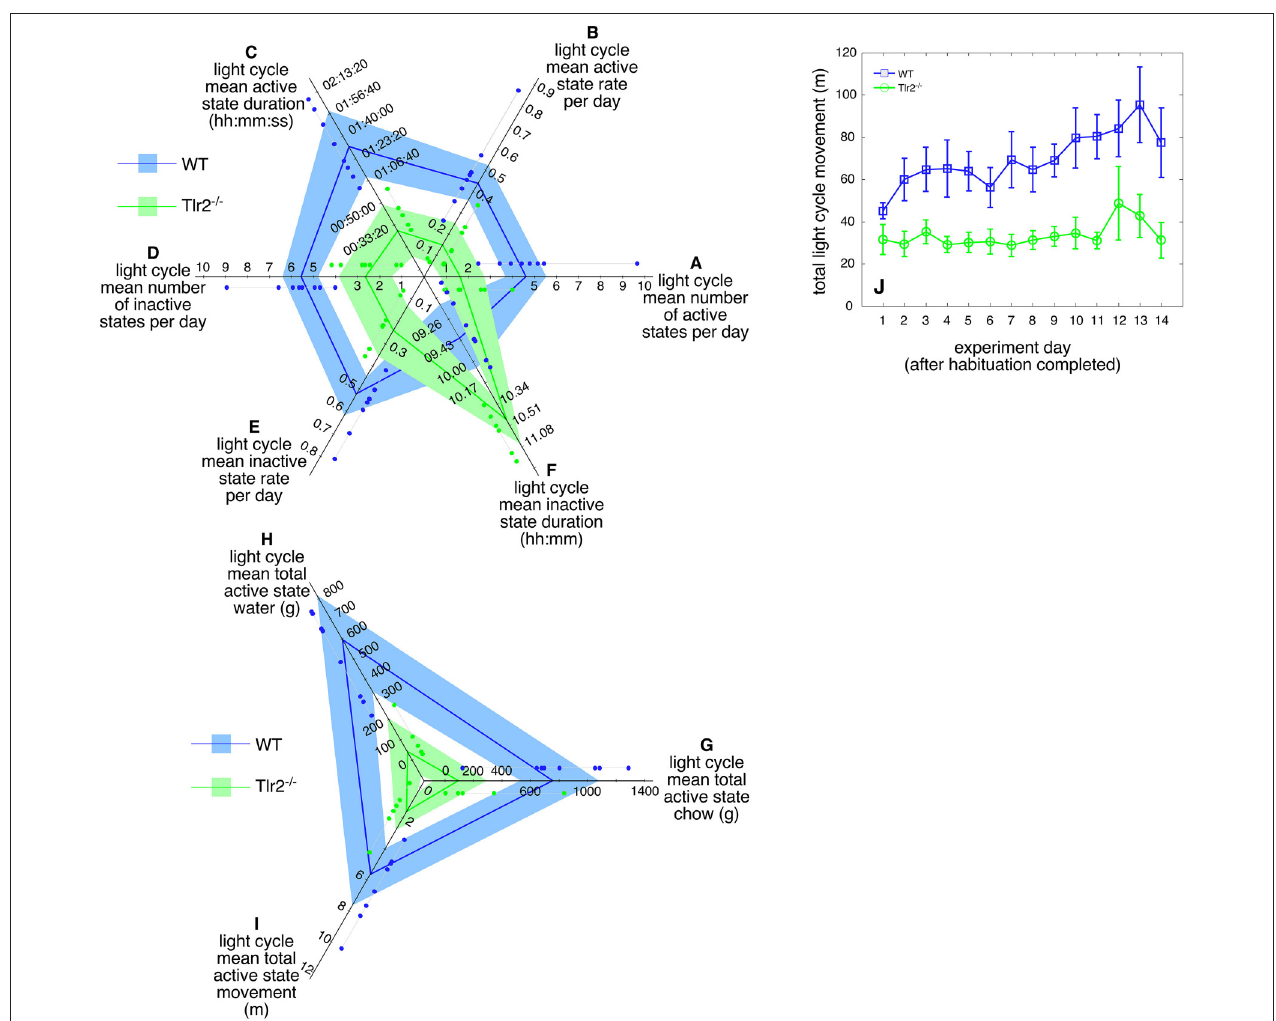
FIGURE 3 | 4–4.5 months old Tlr2 − / − mice demonstrate dramatic behavioral consolidation during the circadian light cycle. Polygon plots of significant light cycle active and inactive state properties (A) . Number of circadian light cycle active states. Light blue region spans the first through third data quartiles for all WT mice; the dark blue line depicts property median values for WT. Similarly, light green region spans the first through third data quartiles for all Tlr2 − / − mice; the dark green line depicts property median values for all Tlr2 − / − . Thin gray lines group data points for each genotype/property combination; these values are offset from their corresponding axis for clarity (B) . Circadian light cycle active state rate (C) . Circadian light cycle active state duration (D) . Circadian light cycle number of inactive states (E) . Circadian light cycle inactive state rate (F) . Circadian light cycle inactive state duration (G) . Circadian light cycle chow consumption (H) . Circadian light